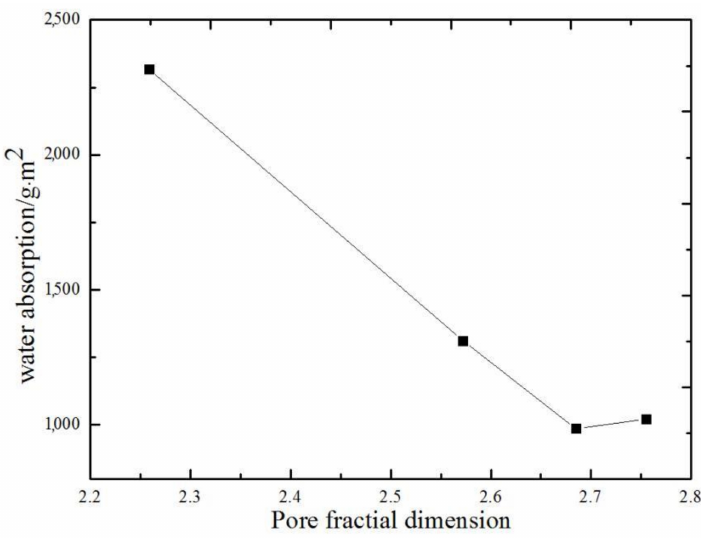
Figure 15. Relationship of water absorption value and fractal dimension of 50~550 nm (28 days cured concrete).